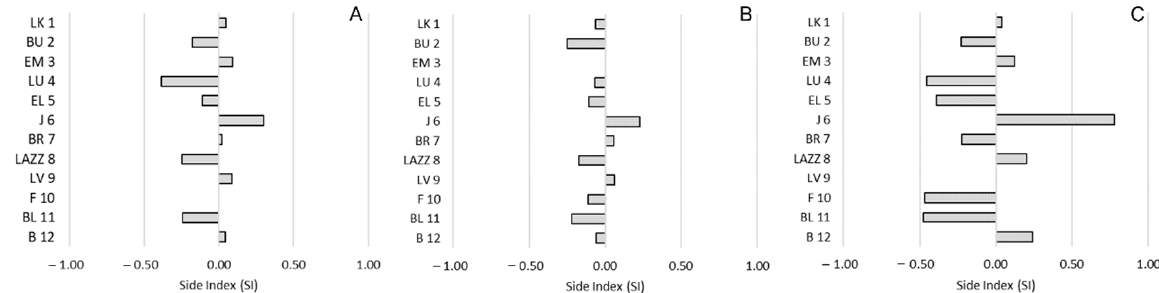
Figure 4. Bias of side preference (SI) and social hierarchy in Barbary macaques . Individuals (y-axis) are presented according to their social rank from 1 (the most dominant macaque) to 12 (the most dominated macaque), based on the CBI. ( A ): approach; ( B ): proximity; ( C ): affiliative contacts.